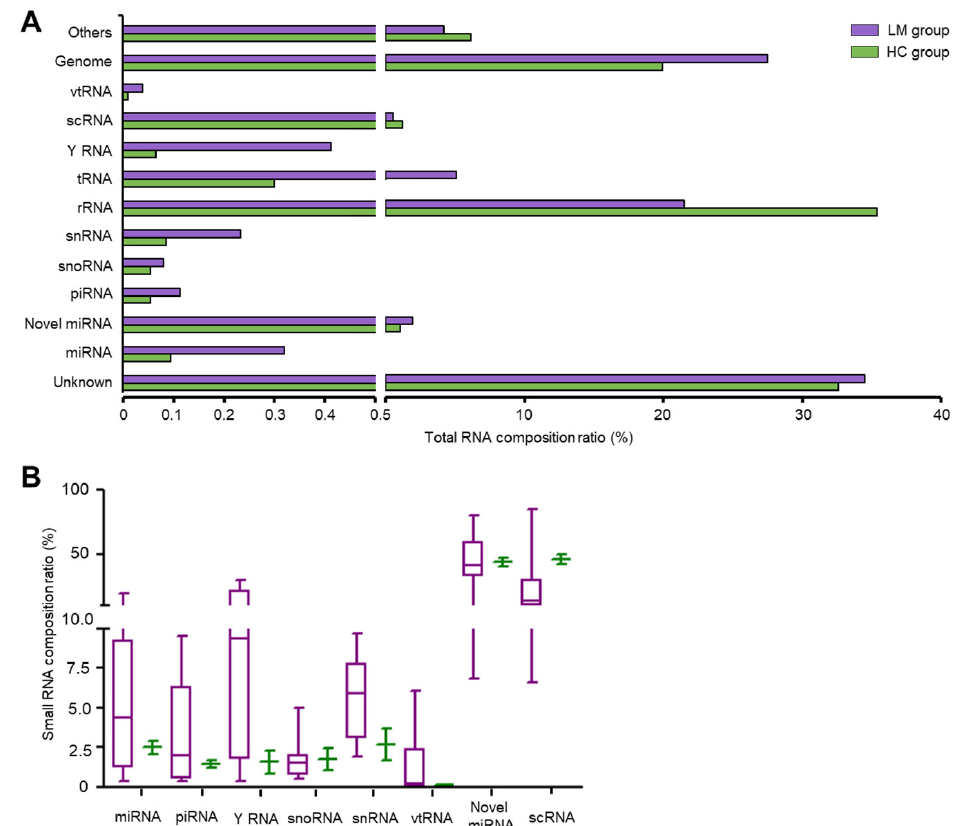
Figure 2. The proportion of smRNA subtypes showed biased expression between CSF EVs from LM and healthy control (HC). ( A ) smRNA sequencing data were processed for 10 types of general sm RNAs subclasses including genome and unknown population in RNA central database. Bar graph showed the average percentage of each smRNA subtype. ( B ) After removing reads mapped to rRNA, tRNA, and others, eight subtypes (miRNA, piRNA, Y RNA, snoRNA, snRNA, vtRNA, novel miRNA, and scRNA) of biologically intriguing smRNAs were processed. Boxplot showed the median percentage value and interquartile range of each smRNA subtypes. (LM, purple box, n = 8; HC, green bar, n =